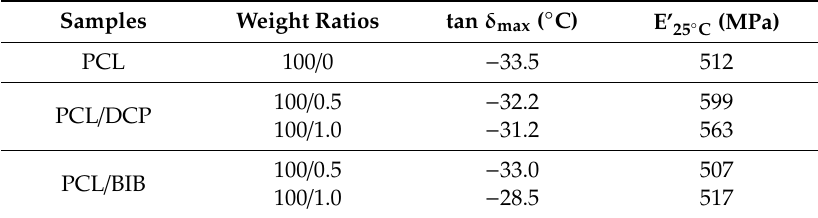
Figure 6. Loss angle (tan δ ) for PCL modified by DCP ( a ) and PCL modified by BIB ( b ). Table 3. The dynamic mechanical analysis parameters of PCL and PCL modified by peroxides. Samples